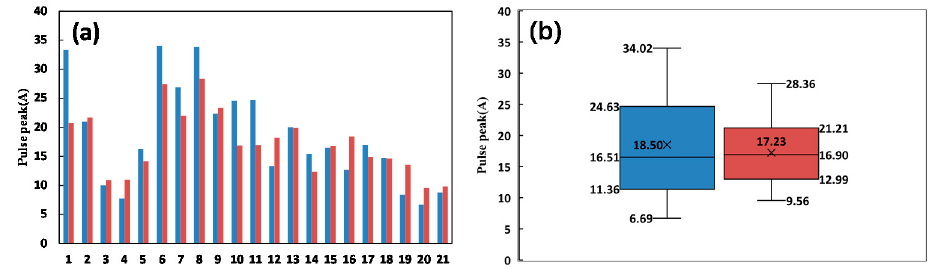
Figure 9. Average pulse peaks of PCP clusters and IPCPs. ( a ) Statistics of each case. ( b ) Overall statistics of all cases. The blue is the PCP clusters and the red is the IPCPs.